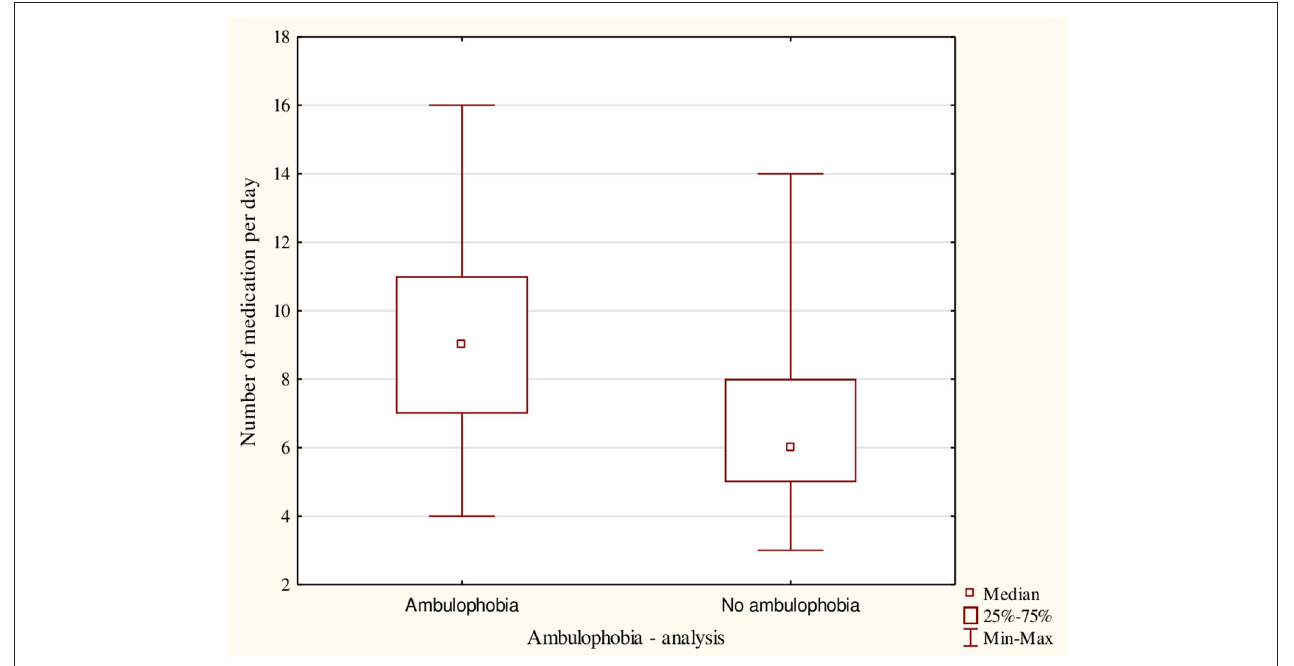
FIGURE 1 | The number of medications taken among all participants including the presence of